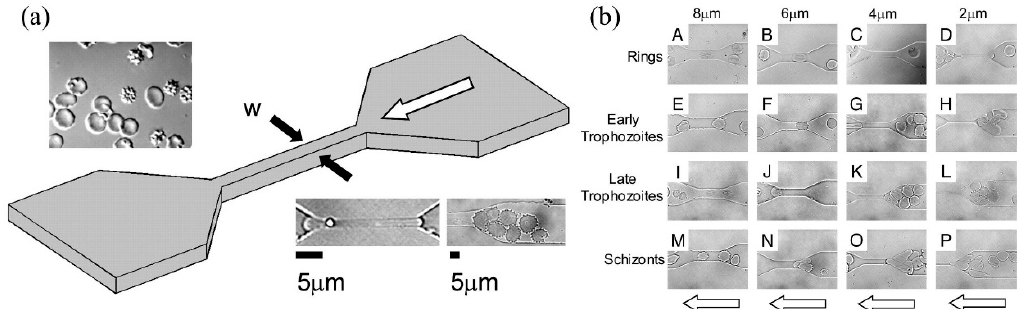
Figure 1. ( a ) Schematic illustration of the geometry of the constriction channel design which was sized at 8, 6, 4, and 2 μ m in width. (Upper Inset) An image of normal (smooth) and infected RBCs. (Lower Inset) A normal RBC was passing through a 2- μ m constriction and infected RBCs blocked a 6- μ m constriction channel. ( b ) Four stages of malaria-infected RBCs through the constriction channels. Ring-stage infected erythrocytes were able to pass through all constriction channels. Early trophozoite and late trophozoite infected cells passed through the larger 8- and 6- μ m channels but eventually blocked the smaller 4- and 2- μ m channels. Schizont stage infected erythrocytes blocked all but the 8- μ m channels. The arrows indicate direction of flow. Reproduced with permission from [23].